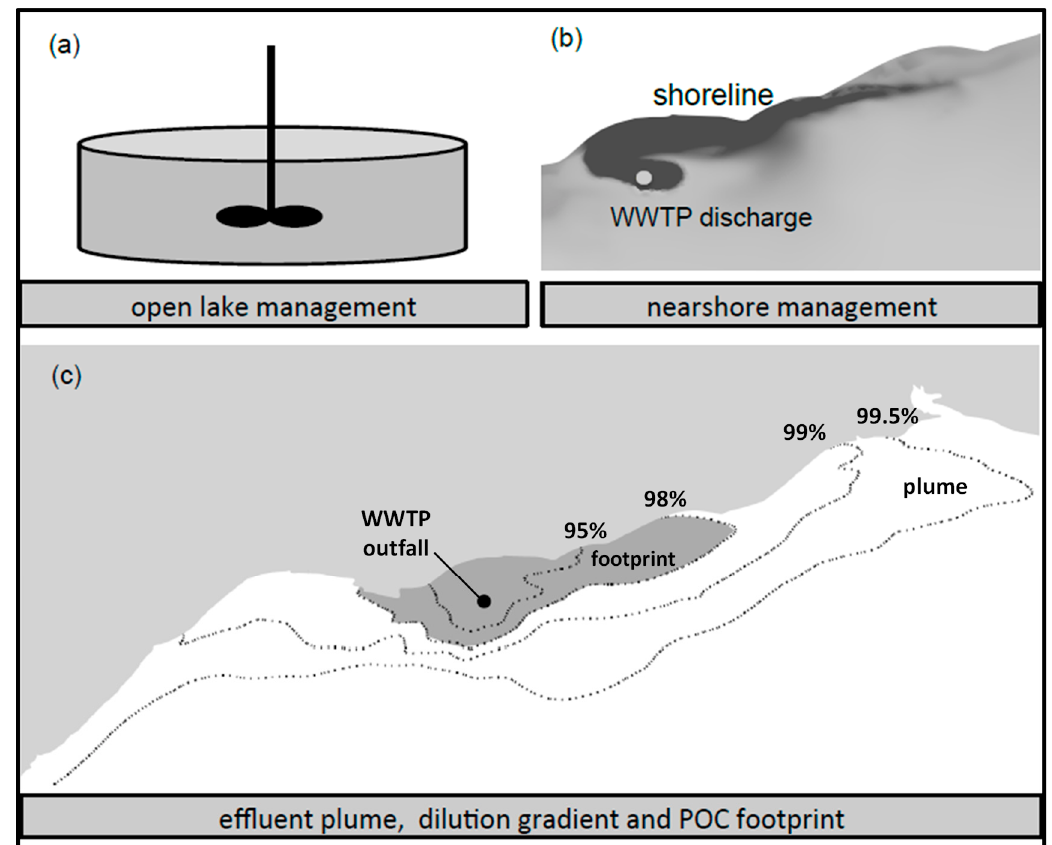
Figure 1. Conceptualization of water quality management in ( a ) an open lake and ( b ) a nearshore context, and ( c ) an effluent plume, over which a dilution gradient (dashed lines) is manifested, as well as the footprint for a pollutant of concern (gray shading). The extent of the plume is set arbitrarily at the 99.5% dilution isopleth and represents the confluence of water containing effluent and the unimpacted boundary condition. The extent of the footprint is set at the 98% dilution isopleth for this example.